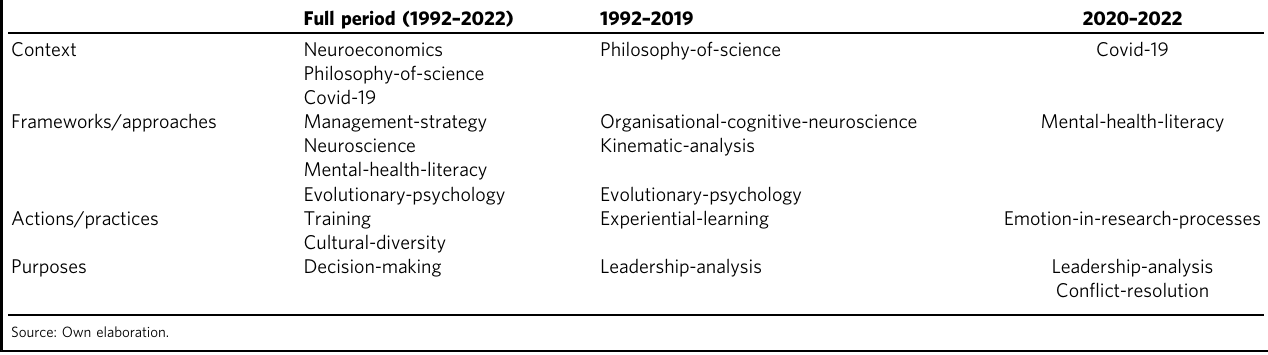
Table 1 Thematic analysis model by periods.